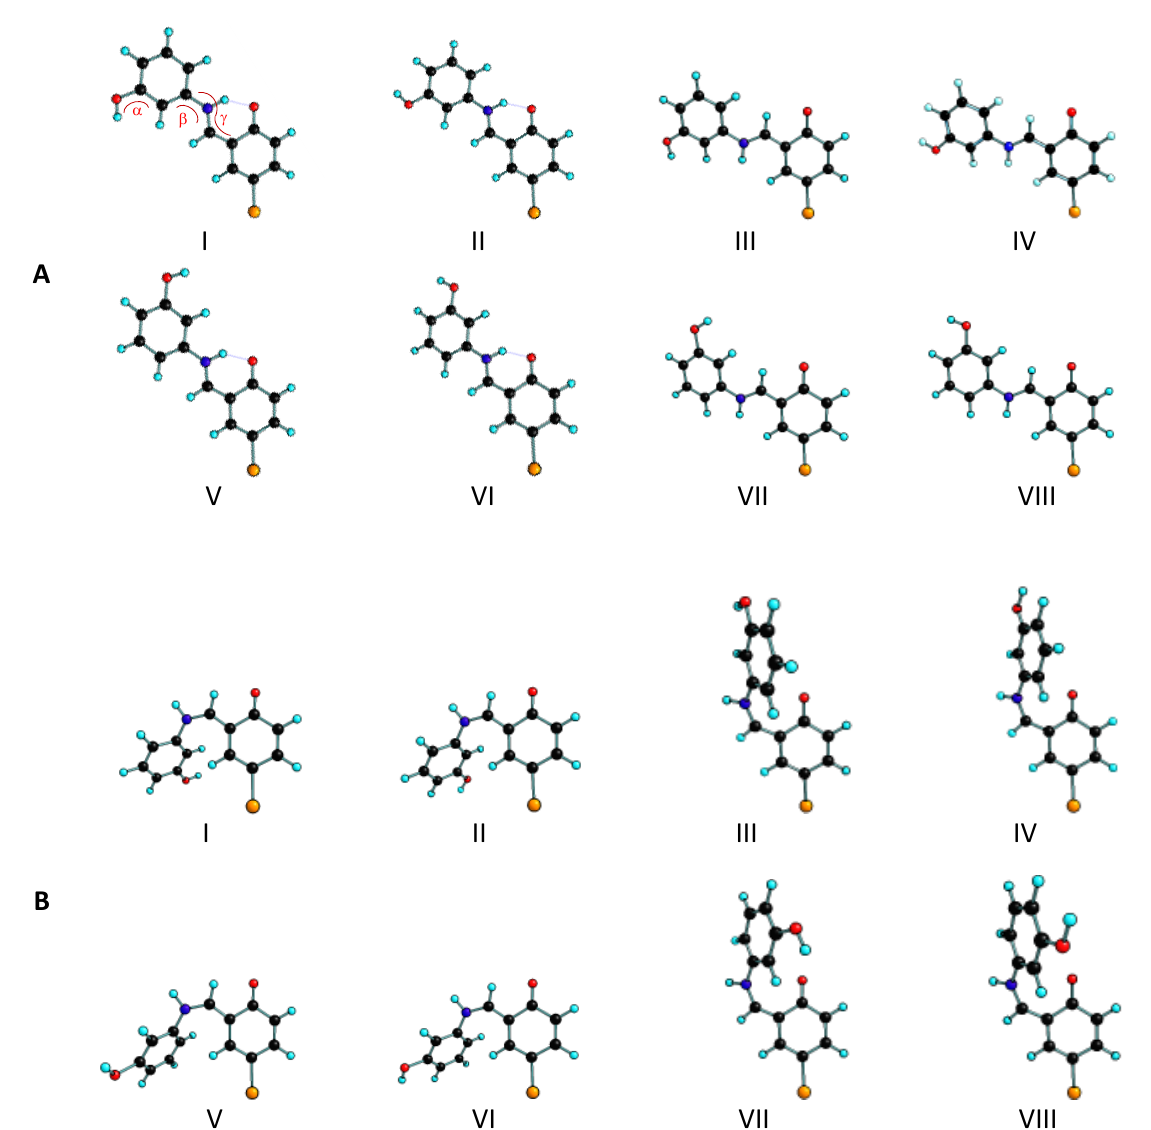
Figure 4. Conformers of the BHAP keto-amine forms: ( A ), keto-amine forms structurally related to the E -enol-imine tautomer; ( B ), keto-amine forms structurally related to the Z-enol-imine tautomer. B3LYP/6-311++G(d,p) calculated optimized Cartesian coordinates of each conformer are provided in the Supporting Information Table S1. The conformationally relevant dihedral angles α , β , γ are indicated over the structure of conformer I ( A ). Note that all conformers have a symmetry related structure.